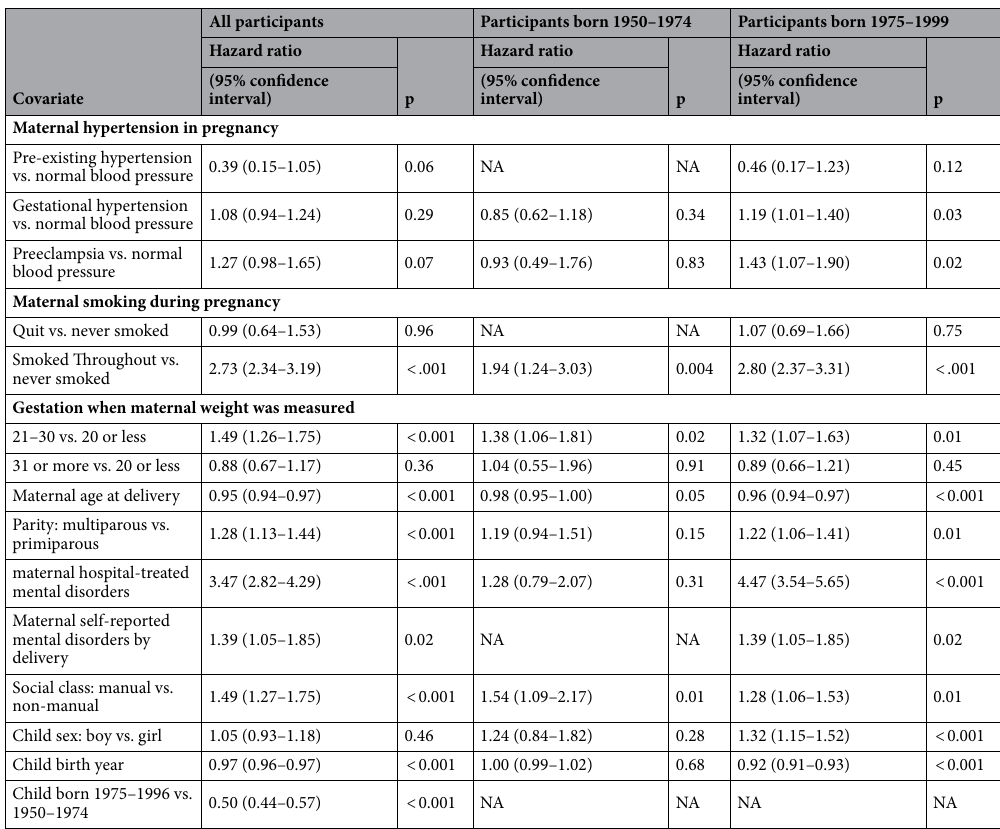
Table 3. The associations of the covariates with offspring hazard of mental disorders among all participants and participants born 1950–1974 and 1975–1999. Hazard ratios and their 95% Confidence intervals refer to the hazard ratios and 95% confidence intervals of any mental disorder in the offspring. NA not